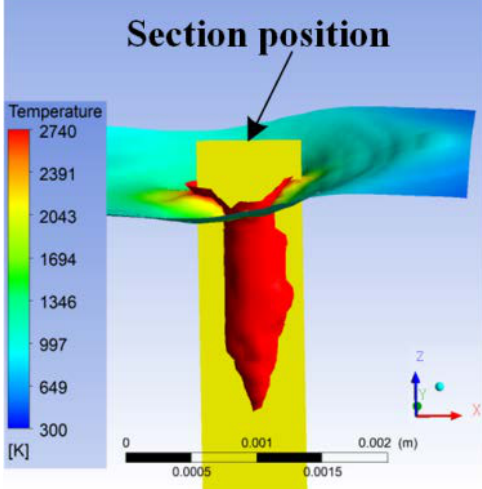
Figure 3. Section position of the keyhole wall.